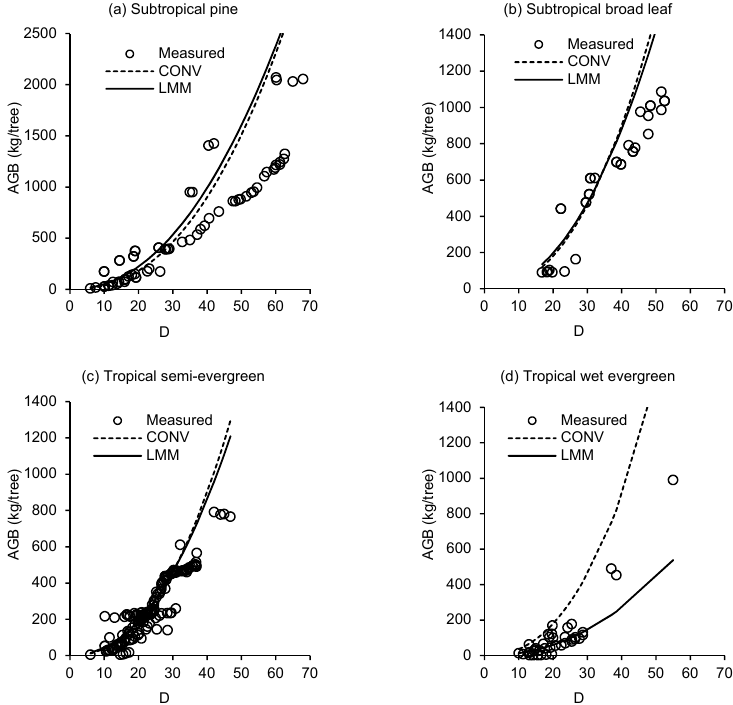
Figure 3. The observed AGB (open circles) and fitted lines for the four forest types produced using the second highest rated model (Model 1) in the arithmetic domain. The dashed fitted lines represent